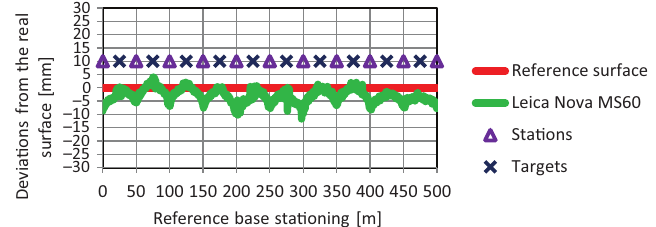
Figure 9. Deviations from the real surface in a longitudinal cross-section